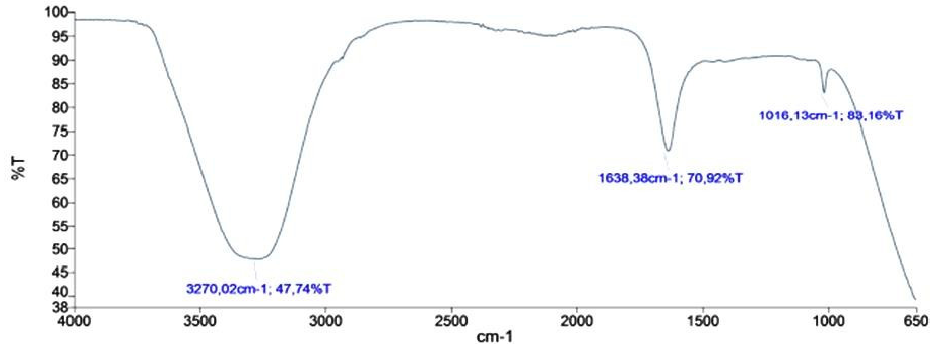
Figure 6. FTIR spectrum of as-synthesized AgNPs.